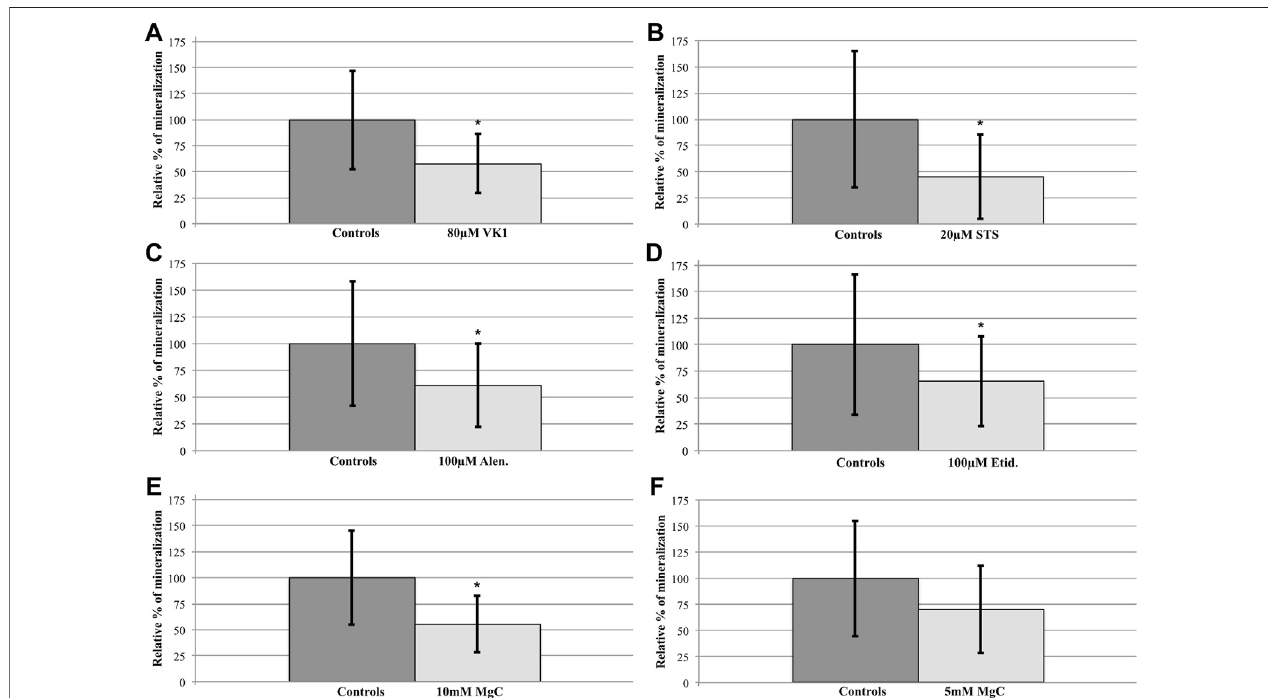
FIGURE2| Compound treatmenteffectsonthe abcc6a cmg52/cmg52 spinal hypermineralization phenotype. Aftersemiquanti fi cation and statistical analysis, mean ± SD percentile valuesofthespinal mineralization werenormalized per compound totherespectivecontrol valuesoftheuntreatedabcc6a cmg52/cmg52 fi sh. (A) 80 µM VK1 (58±28)versusC(100±48),42%reduction (B) 20 µMSTS(45±40)versusC(100±65),55%reduction (C) 100 µMEtid. ( 65±43)versusC(100±67),35%reduction (D) 100 µM Alen. (61 ± 39) versus C (100 ± 58), 39% reduction (E) 10 mM MgC (55 ± 27) versus C (100 ± 55), 45% reduction (F) 5 mM MgC (70 ± 42) versus C (100 ± 55), 30% reduction. Treatments resulted in signi fi cant reductions (* p < 0.05), except for 5 mM